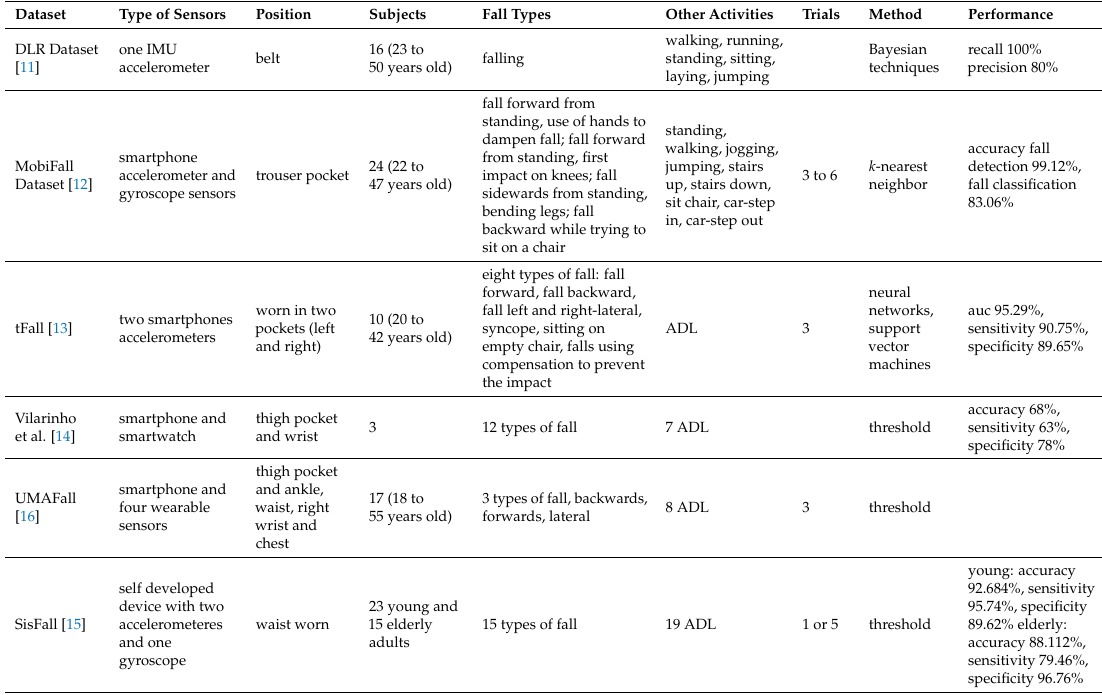
Table 1. Wearable-based databases for fall